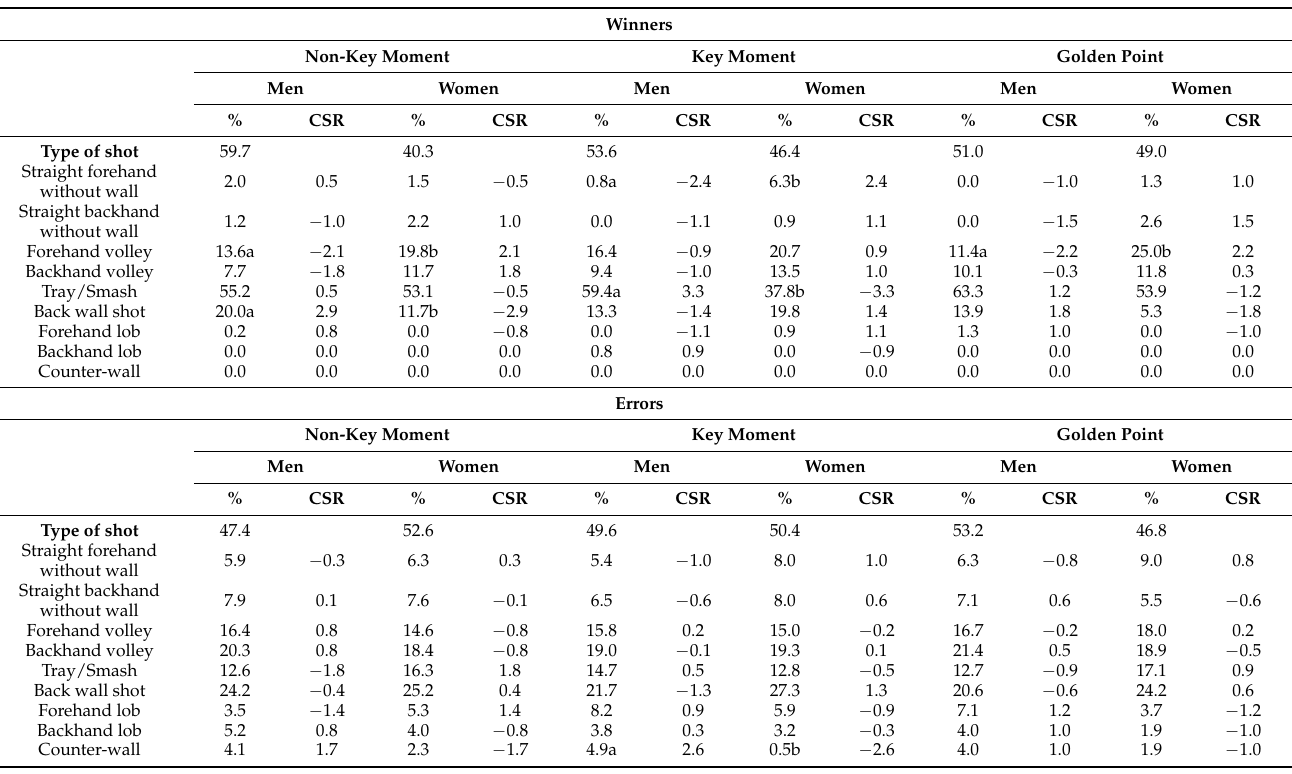
Table 2. Men’s padel, women’s padel, and their relationship according to the type of shot and the game situation in winning shots and